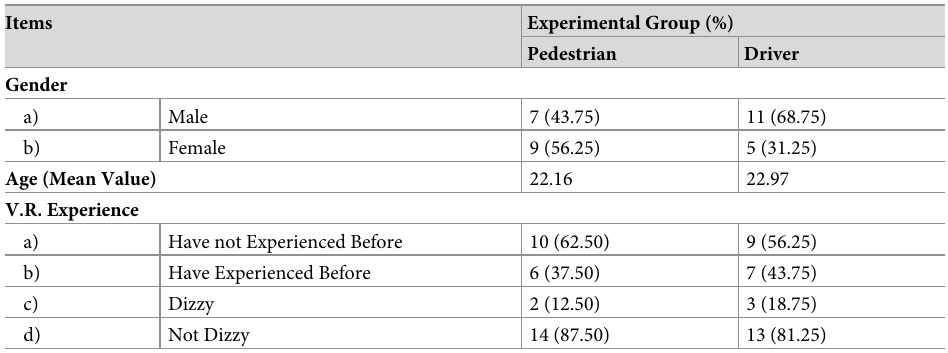
Table 3. Demographic information.